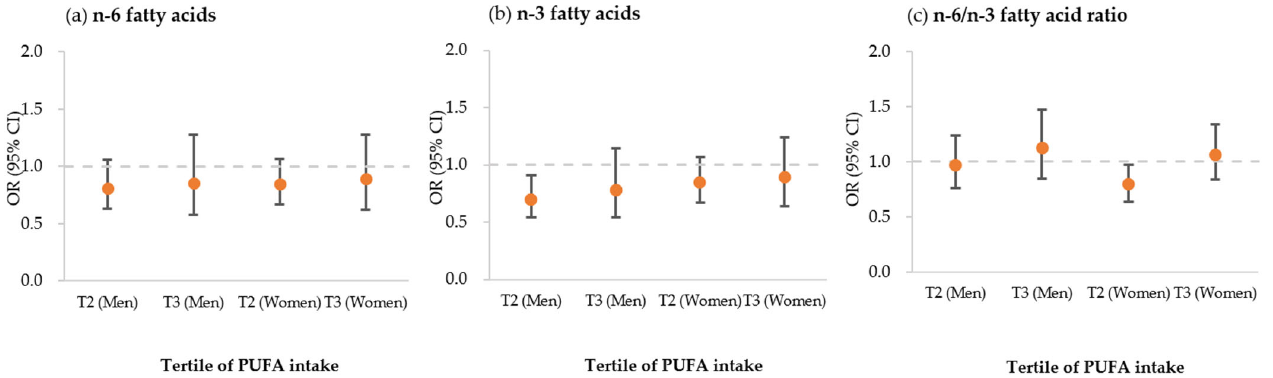
Figure 2. Associations between a tertile increase in PUFA intake and prevalence of metabolic syndrome for ( a ) n-6 fatty acid, ( b ) n-3 fatty acid, and ( c ) the n-6/n-3 ratio using the odds ratio (OR). ORs were adjusted for age, smoking status, alcohol use frequency, education level, employment status, lowest income quartile, physical activity, and daily intake (energy, carbohydrates, protein, saturated fatty acid, monounsaturated fatty acid, cholesterol, and dietary fiber). Error bars represent the 95% confidence interval for each point estimate. Tertile values for each PUFA intake are provided in Table 2.